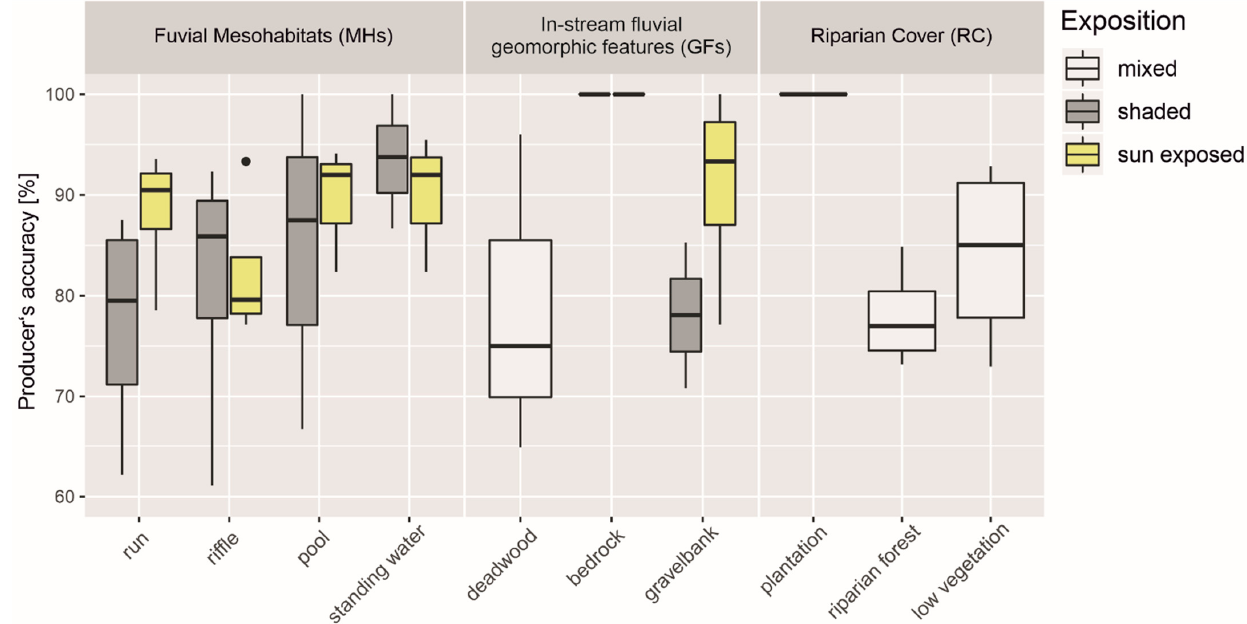
Figure 3. Boxplots of RGB imagery classification accuracy (Producer’s accuracy in %) for each fluvial mesohabitat (MH), in-stream fluvial geomorphic feature (GF), and riparian cover (RC) classes. Boxes show the 25–75% quantiles, with the thick horizontal line indicating the median. Whiskers indicate the minimum and maximum values.